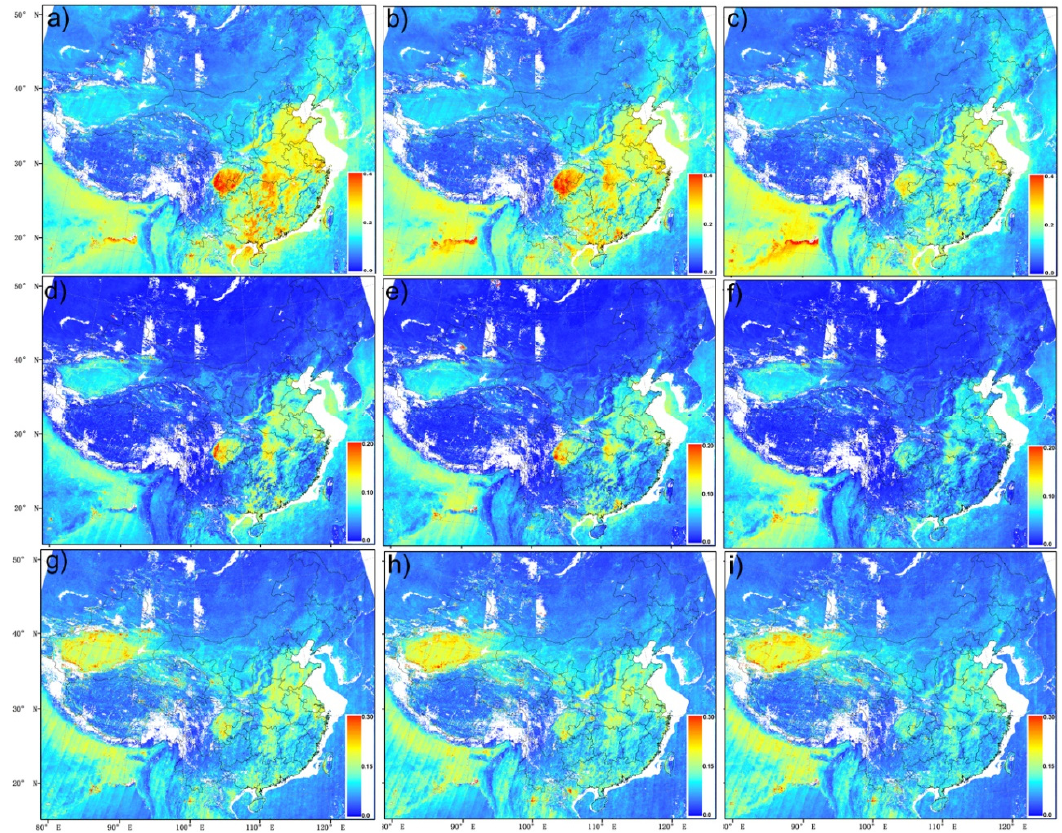
Figure 8. MISR ( a – c ) small-mode, ( d – f ) medium-mode, and ( g – i ) large-mode AOD in 2003–2007, 2008–2012, and 2013–2018, respectively.